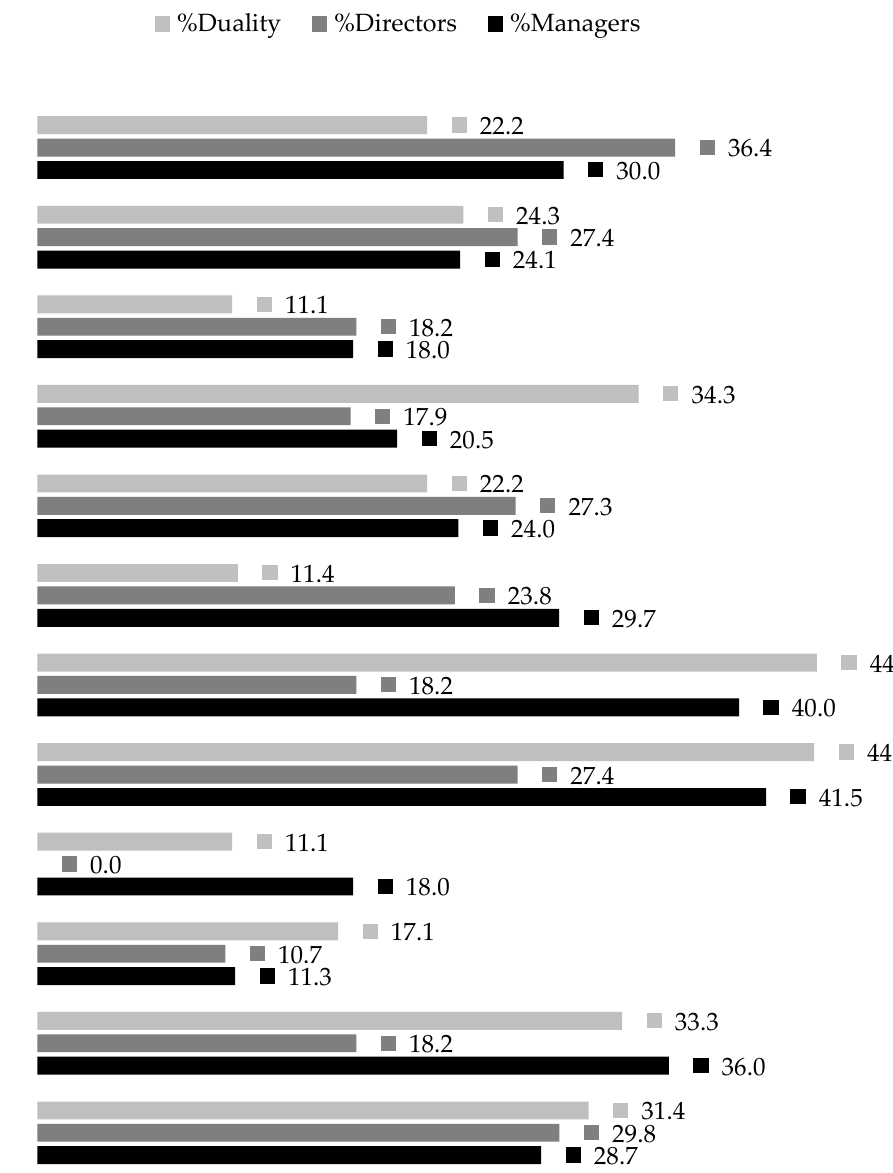
Figure 3. Distribution of the IBEX 35 companies Management Teams by position, gender, and training type. Source: SABI database. IBEX companies’ annual reports.